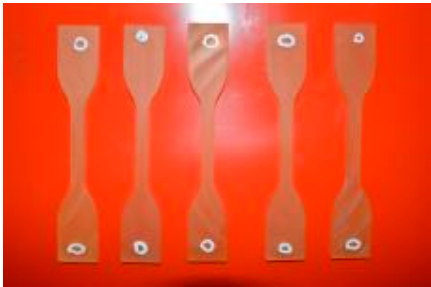
Figure 2. Tensile test samples of epoxy resin.